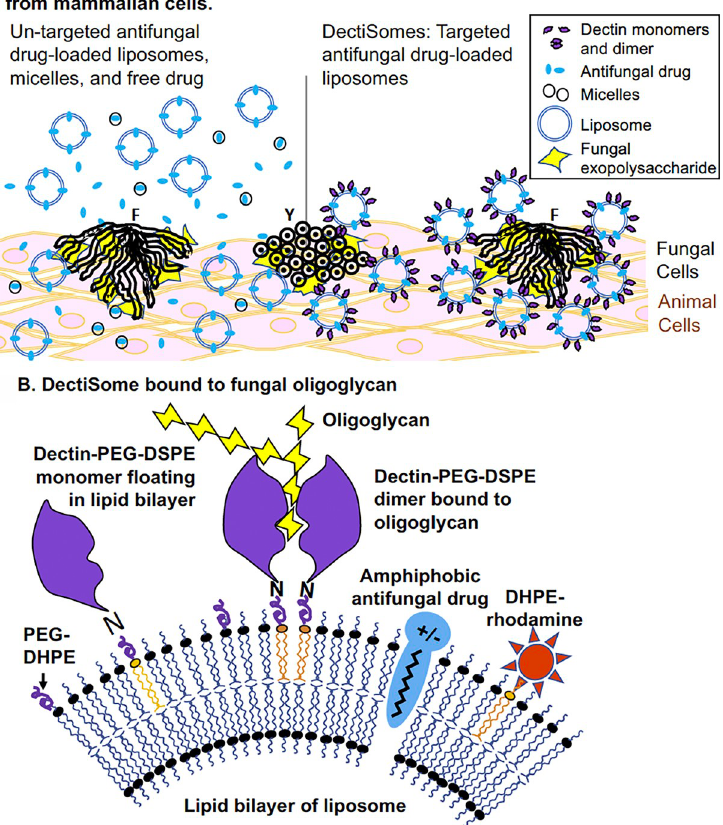
Fig 1. DectiSomes are designed to target antifungal drugs specifically to fungal cells. (A) Coating antifungal drug- loaded liposomes with glycan-binding proteins concentrates drugs on fungal cells. Current antifungal drugs are untargeted (left side). Having no selective affinity for fungal cells over host cells demands higher doses of antifungal drugs to inhibit or kill fungal cells. DectiSomes (right side) are drug-loaded liposomes coated with the glycan recognition domains of glycan-binding host receptors such as dectins. They bind specifically to fungal cell walls and their extracellular matrices within biofilms, which reduce the effective dose needed to clear fungal infections and host toxicity. Infection sites composed of fungal cells with Y or F morphologies are shown. ( B) Structure of a DectiSome. One iteration of a DectiSome is an antifungal drug-loaded liposome coated with the glycan recognition domain of a Dectin. We coupled its glycan-binding domain (purple globular structure) to a lipid carrier to make DEC-PEG-DSPE, which is intercalated into the liposomal membrane via the DSPE moiety. Dectin monomers floating in the liposome membrane form dimers as they bind to fungal oligoglycans (yellow sugar moieties). Rhodamine-B-DHPE is intercalated via its DHPE moiety to allow fluorescent monitoring of liposome binding to fungal cells. Amphiphobic antifungal drugs (blue ovoid structure) are positioned within the lipid bilayer of liposomes. Each approximately 100-nm diameter liposome contains approximately 1,500 Dectin monomers, thousands of antifungal drug molecules, and 3,000 rhodamine molecules. DEC AU : TheabbreviationlistinFig 1 hasbeenupdated : Pleaseverifythatallentriesarecorrect : , dectin; DHPE, dihexadecanoyl-glycero-phospho-ethanolamine; DSPE, distearoyl-glycero-phospho-ethanolamine; F, filamentous; PEG, poly(ethylene glycol); Y,